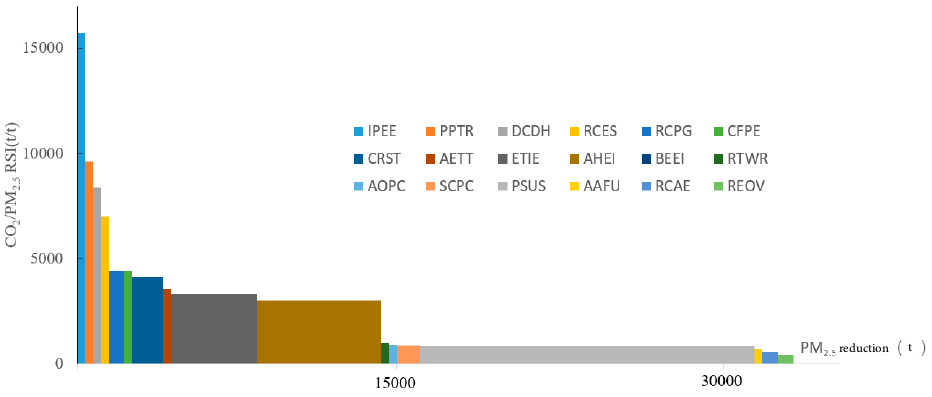
Figure 11. SRC of PM 2.5 and CO 2 emissions in 2030.